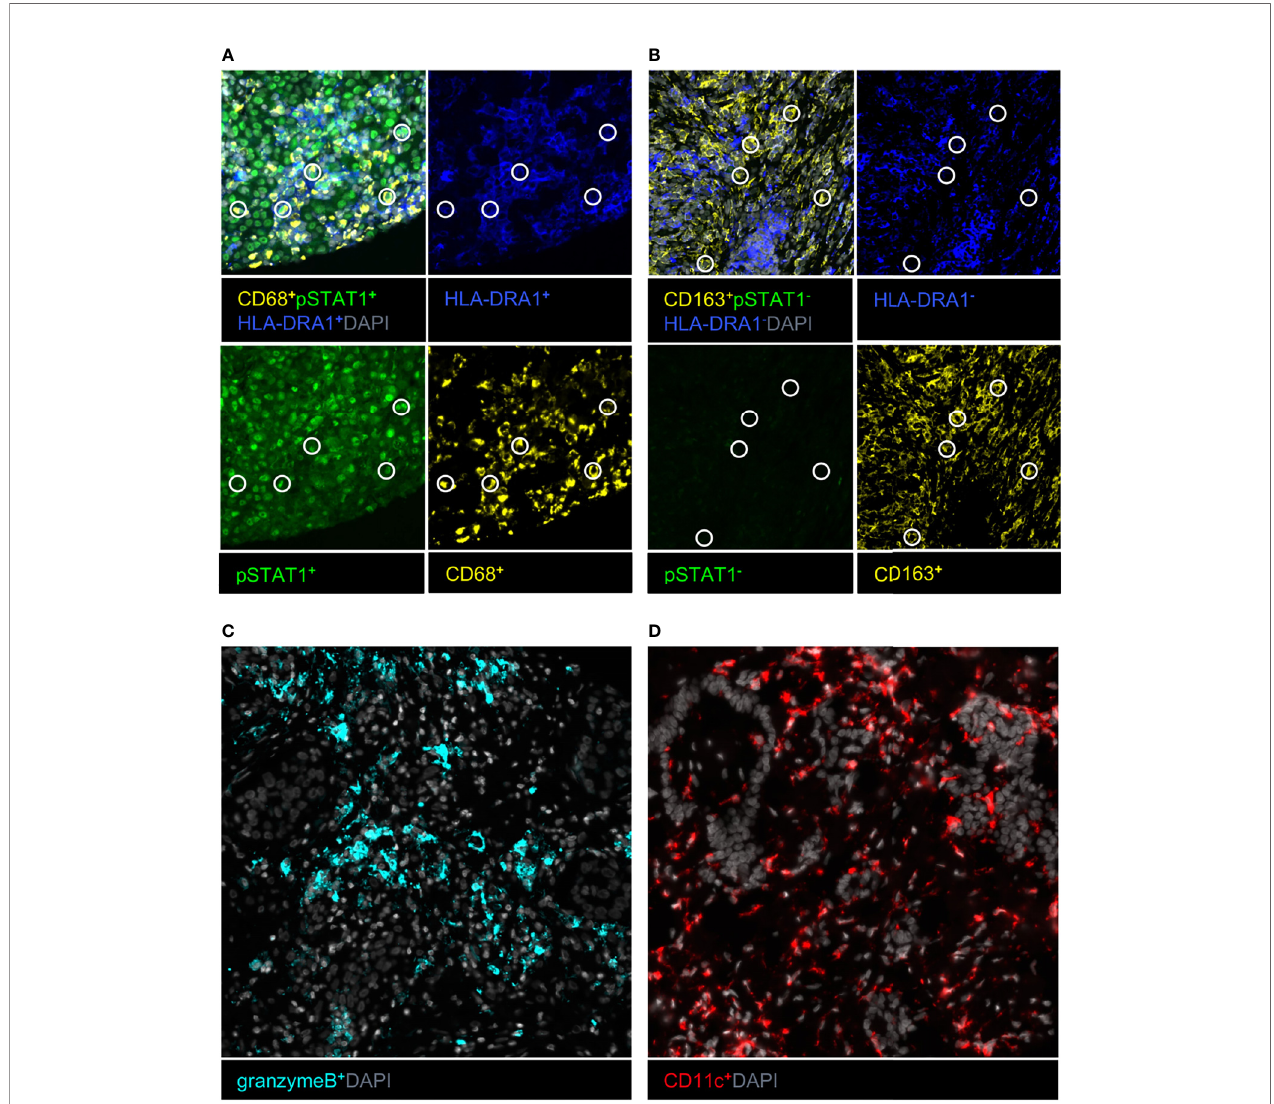
FIGURE 1 | Example images of immune cell phenotypes associated with survival in univariate Cox regression. (A) Type M1 macrophage marker combination with circles indicating a speci fi c marker combination. (B) Type M2 macrophage marker combination with circles indicating a speci fi c marker combination. (C) Granzyme B – positive cells. (D) CD11c-positive